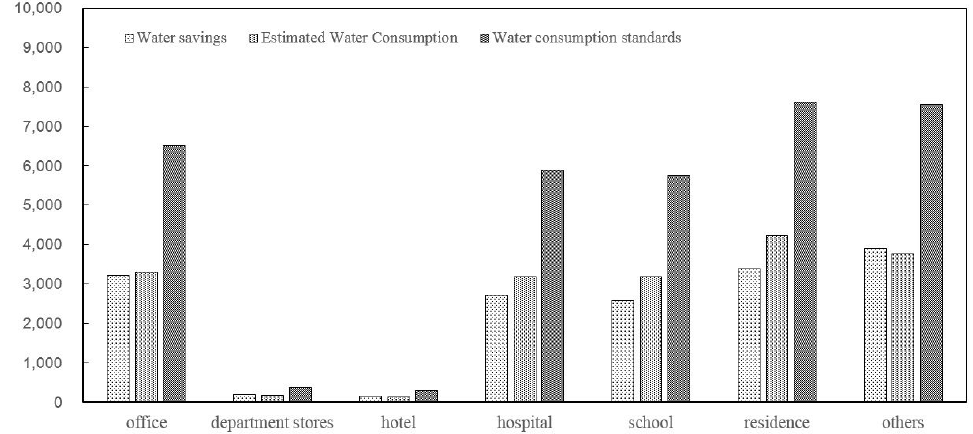
Figure 1. Distribution of water-saving rates for validated cases.